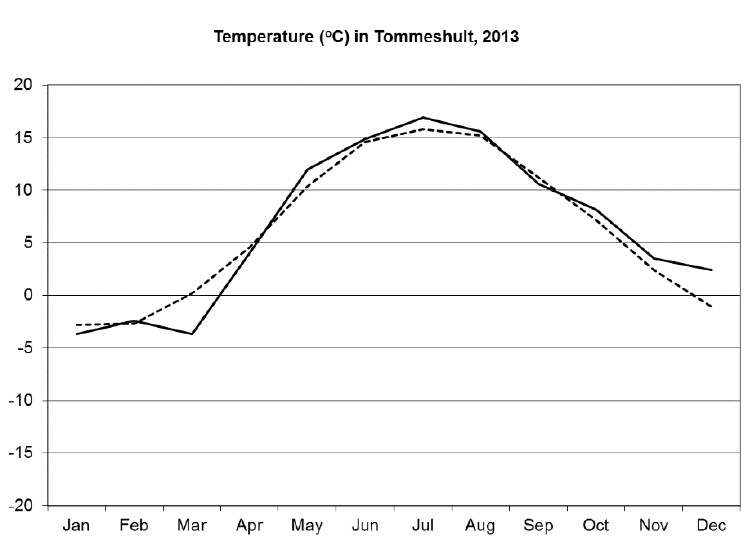
Figure 4. Average monthly temperature in °C at the SMHI weather stations over the study period ( ____ ). The 30-year average values for the same period (1961–1990; -----) are also